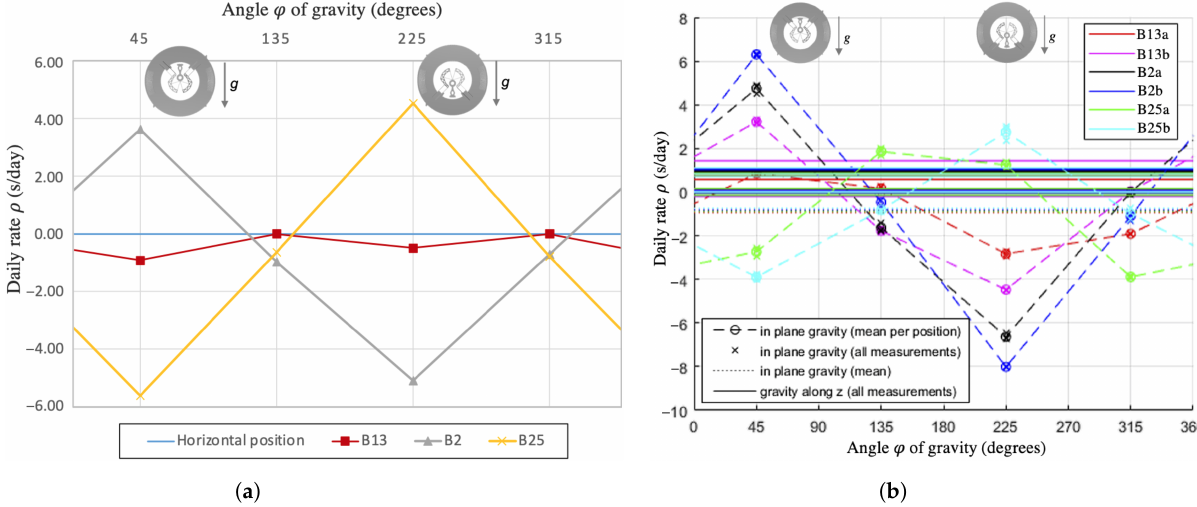
Figure 7. ( a ) FEM and ( b ) experimental validation of the effect of imbalance by varying the COM along the oscillator’s axis of symmetry on its frequency stability for in-plane gravity